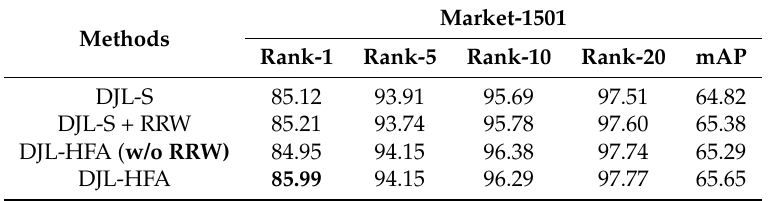
Table 10. Effects of Region Re-Weighting and Hierarchical Feature Aggregation using the base Inception network on Market-1501. Identification accuracy (%) and mAP (%) are reported. The best Rank-1 result is marked in bold.